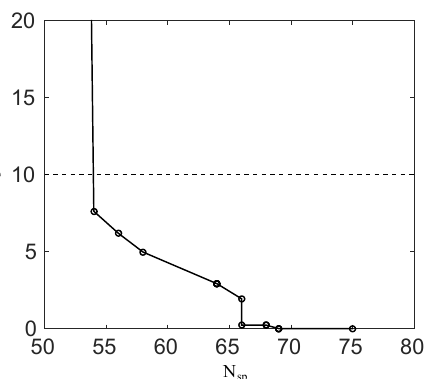
Figure 2. Ozone mixing ratio percentage error against the number of species in the skeletal RACM mechanism.